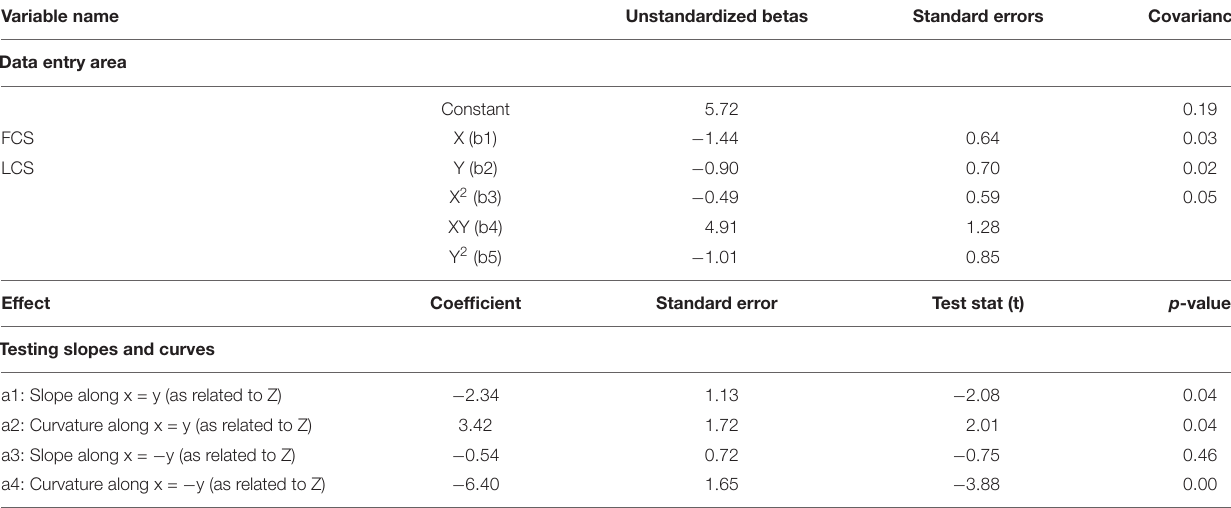
TABLE 3 | The relationship between cognitive similarity in leader-follower dyad and followers’ OCBI.